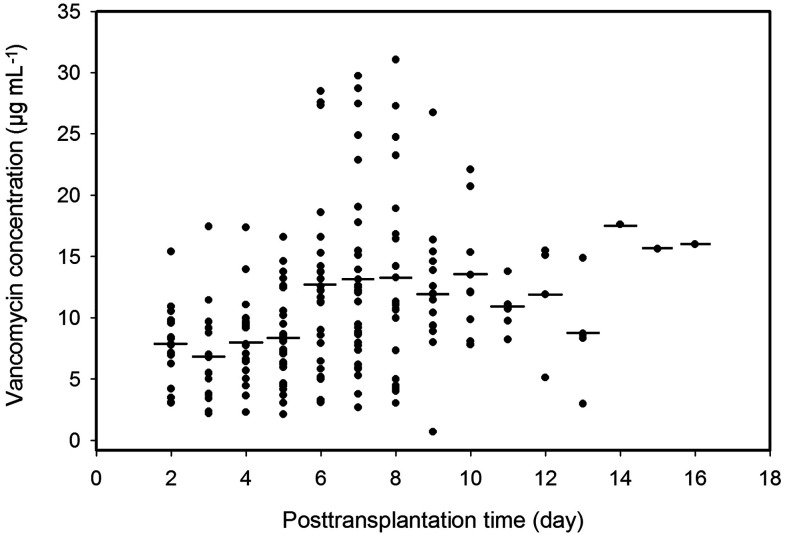
Plasma trough concentrations of vancomycin over time postoperation. Solid dots, observed points of vancomycin concentration; short lines, averages of plasma vancomycin concentrations in the same postoperation day.